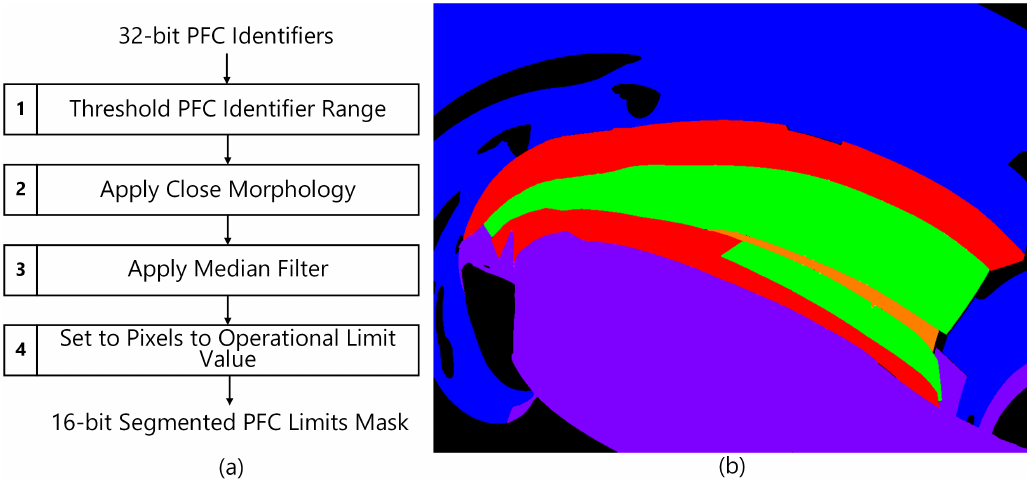
Figure 4. ( a ) Plasma Facing Component (PFC) segmentation pre-processing pipeline. ( b ) Pixel-wise PFC segmentation